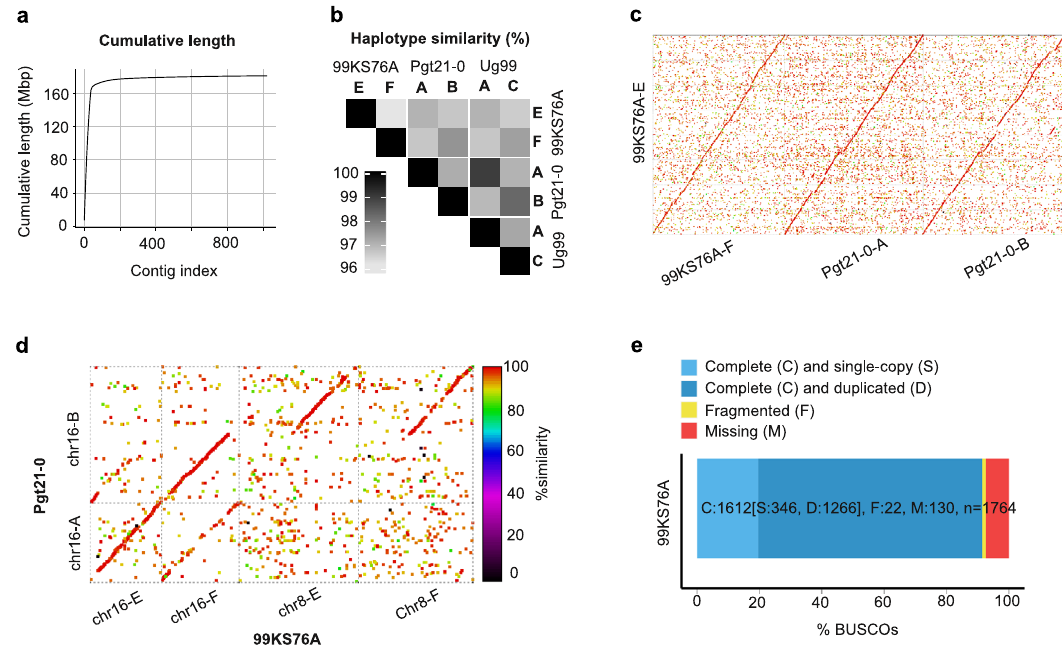
Fig.1|Summaryofthe99KS76A-1genomeassembly.a Cumulativelengthversus the size-rankedscaffolds. b Pairwise comparison of sequencesimilarityamong Pgt haplotypes A,B,C,E,andF. c Whole-genomesequence comparisonofhaplotypeE from 99KS76A-1 with haplotype F from 99KS76A-1, and haplotypes A and B from